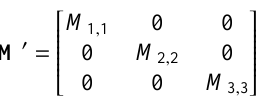
previous one. In this case the circle owns a diameter of 0.1